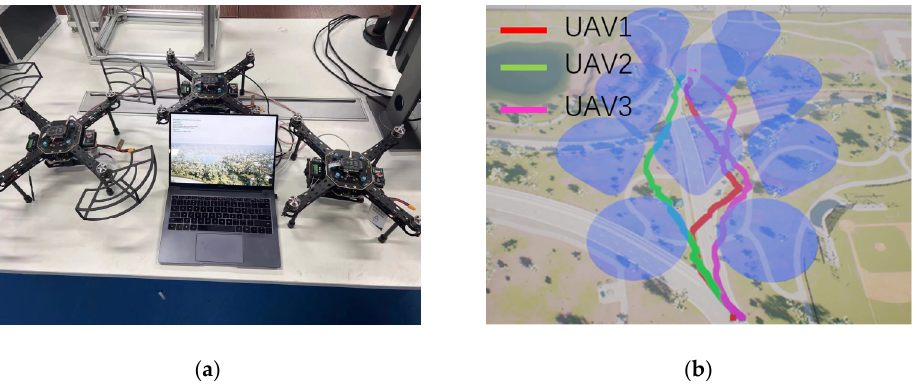
Figure 12. Algorithm verification. ( a ) shows the experimental configuration and ( b ) shows the FF-PPO algorithm’s path planning results. The red, green, and purple tracks represent the tracks of the three drones. It is worth emphasizing that the blue area is completely transparent to the UAVs, and the blue color in the figure is only for the convenience of the reader.